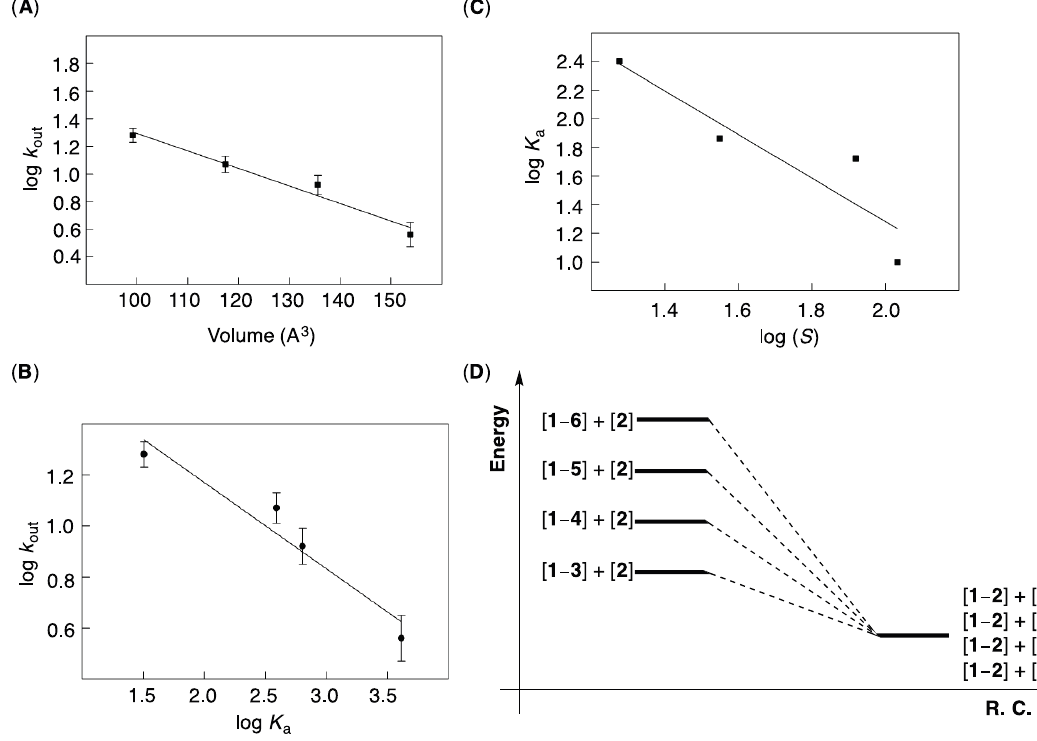
Figure 3. ( A ) A plot showing log k as function of van der Waals volume (Spartan) of out solvents 3 – 6 . The data was fit to a linear function using the least-square method of analysis (R 2 = 0.97, Sigma Plot); ( B ) A plot showing log k as function of the stability log K of out a [ 1 – 2 ] complex in solvents 3 – 6 . The data was fit to a linear function using the least-square method of analysis ( R 2 = 0.94, Sigma Plot); ( C ) A plot showing log K as function of the solubility log S of [ 1 – 2 ] complex in solvents 3 – 6 . The data was fit to a linear function using the least-square method of analysis ( R 2 = 0.94, Sigma Plot); ( D ) Reaction coordinate diagram showing the relative stability of [ 1 – solvent ]